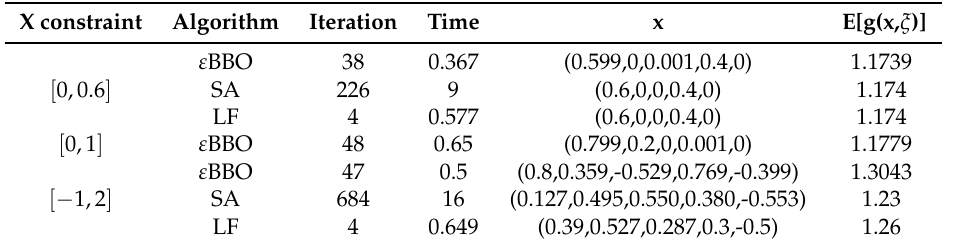
Table 3. The model (29) using date in Table 1. Time is in minute and the expected return of the benchmark portfolio E [ g ( y , ξ )] = 1.073.